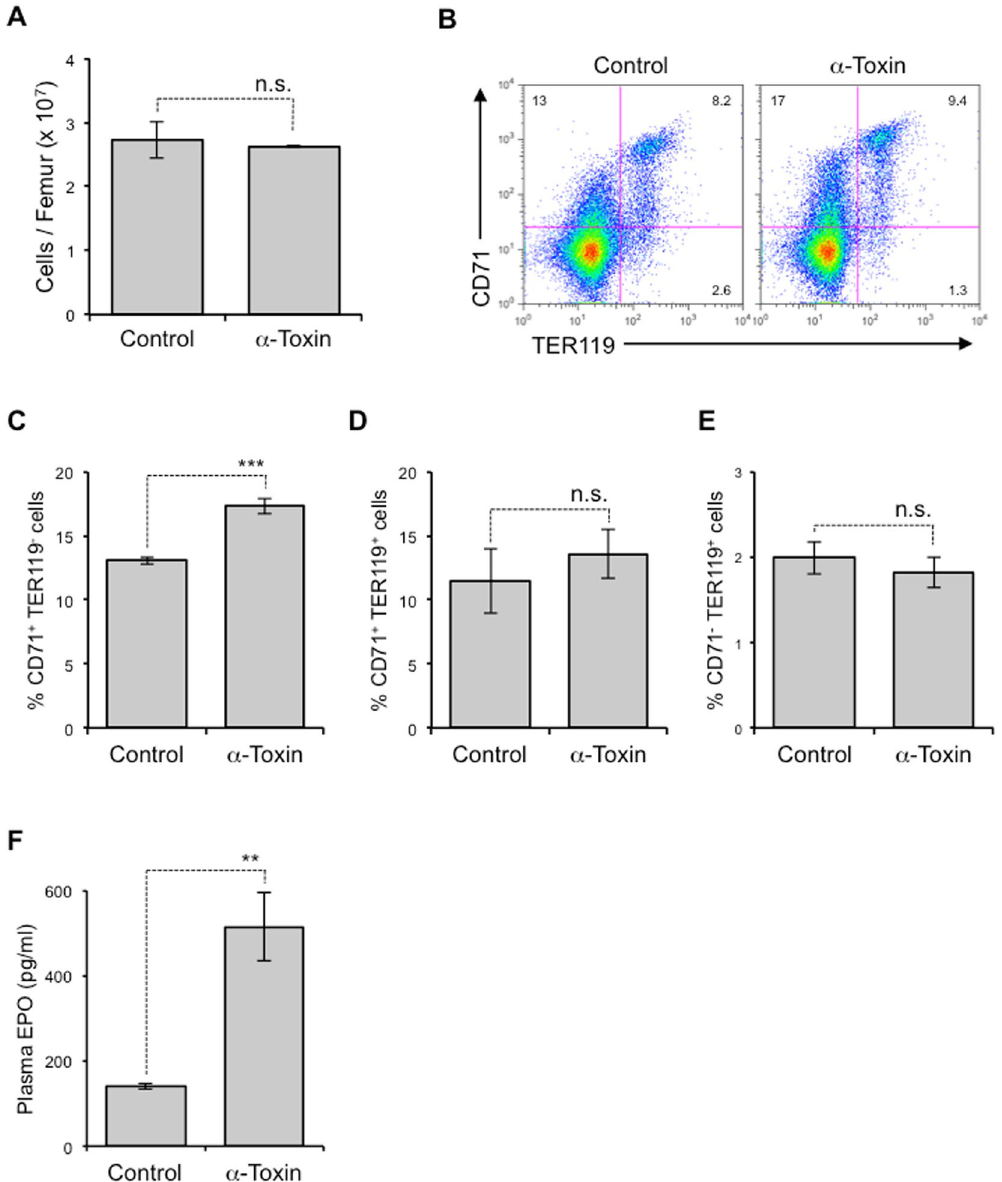
Figure 4. The in vivo effect of α -toxin on erythropoiesis. Mice were injected intraperitoneally with 80 ng of purified α -toxin ( α -Toxin) or PBS as a control (Control). BMCs and peripheral blood were isolated 24 hours after the injection. ( A ) Bone marrow cellularity was determined. ( B – E ) Flow cytometry analysis of BMCs was performed using specific antibodies against CD71 and TER119. A representative flow cytometry profile ( B ), the frequency of CD71 + TER119 − cells ( C ), CD71 + TER119 + cells ( D ), and CD71 − TER119 + cells ( E ) are shown. ( F ) Plasma EPO level was measured by ELISA. Two-tailed Student’s t-test was employed to assess statistical significance. Values are mean ± standard error. ** P < 0.01; *** P < 0.001; n.s., not